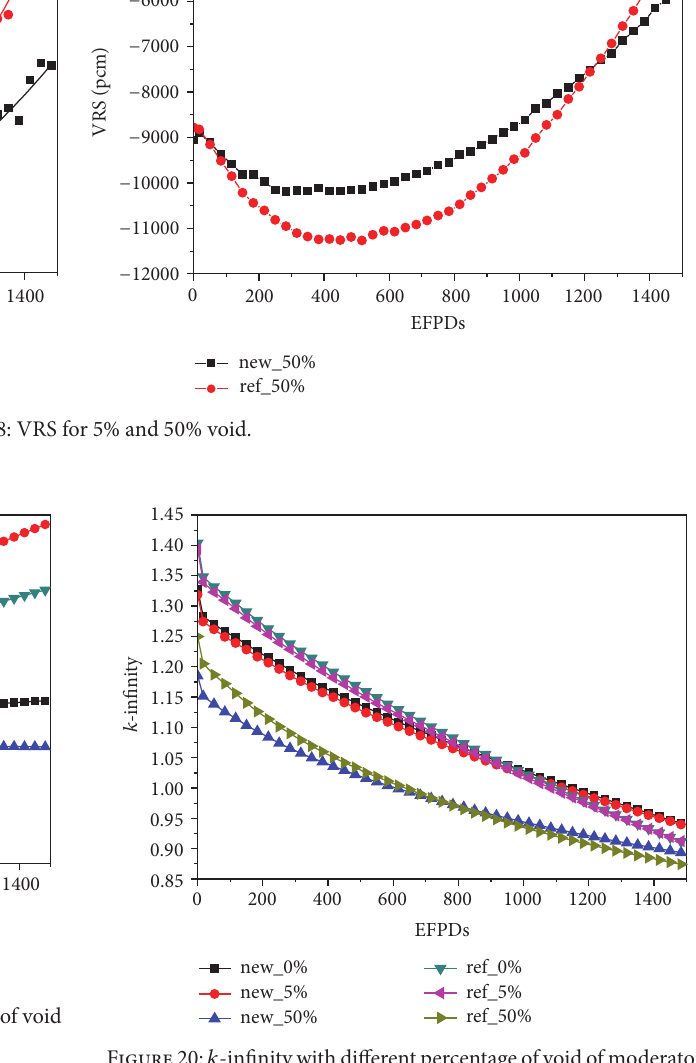
Figure 20: 𝑘 -infinity with different percentage of void of